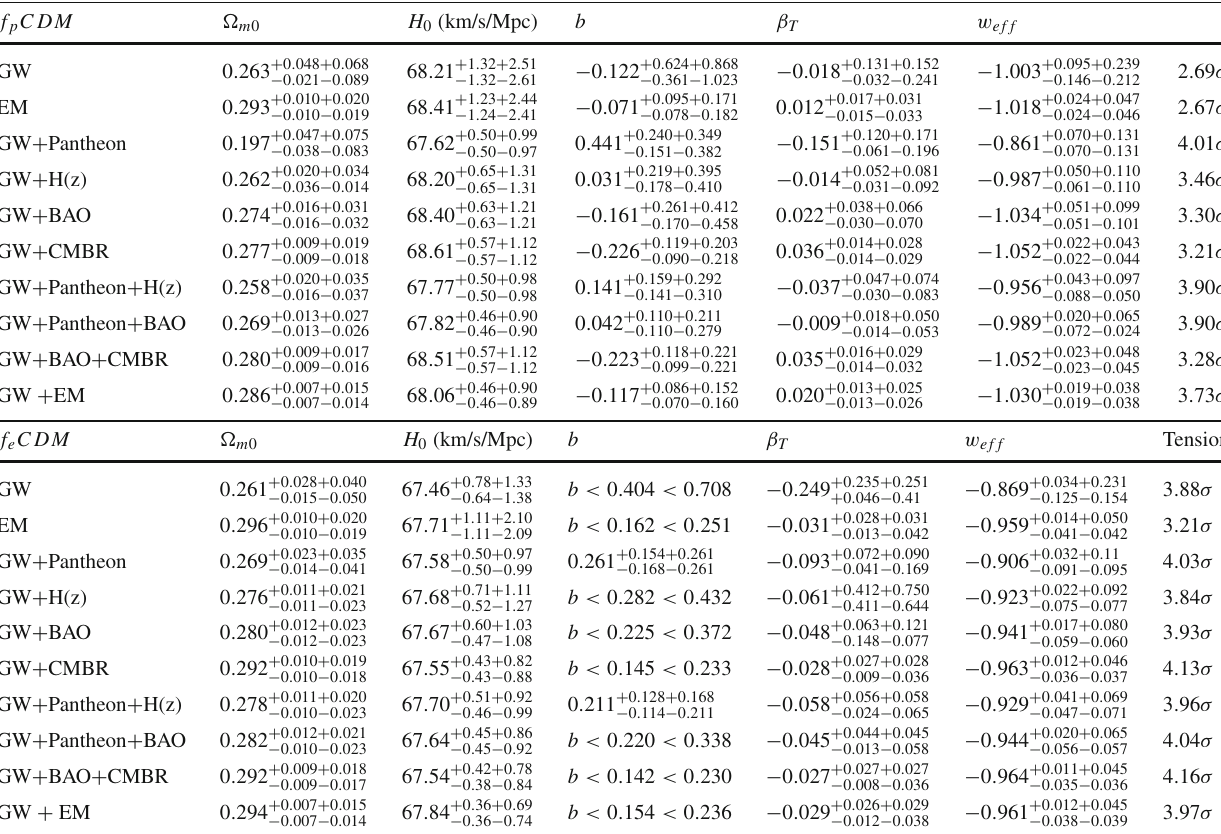
Table 1 Best fitted values with 1 σ and 2 σ standard errors for the GW, EW and GW + EM (combined) data for the f e CDM and f p CDM